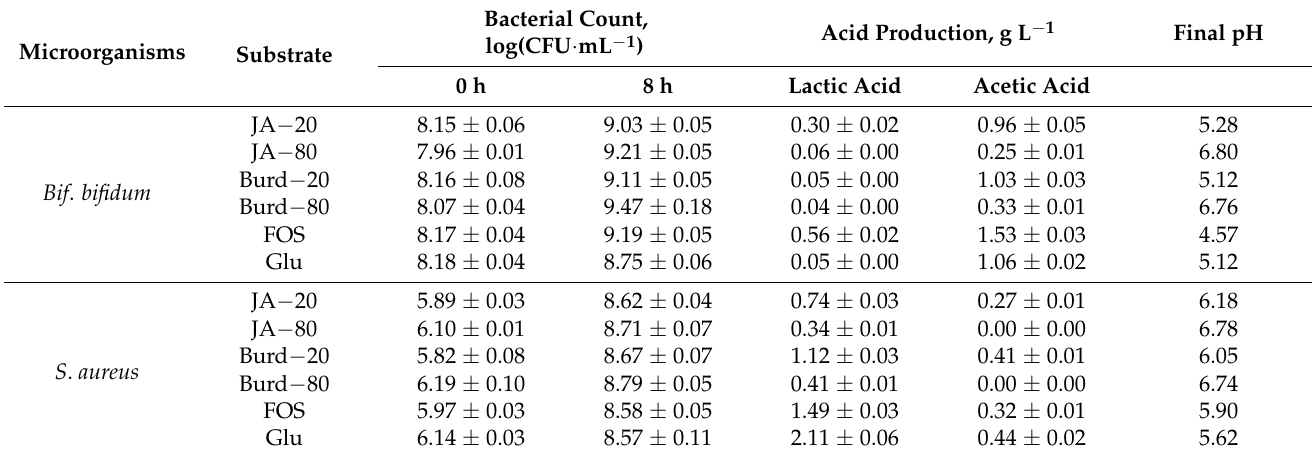
Table 3. The growth characteristics of monocultures S. aureus and B. bifidum on carbohydrate fractions of aqueous extracts of burdock (Burd) and Jerusalem artichoke (JA) precipitated with 20% or 80% ethanol and with control substrates (FOS and glucose